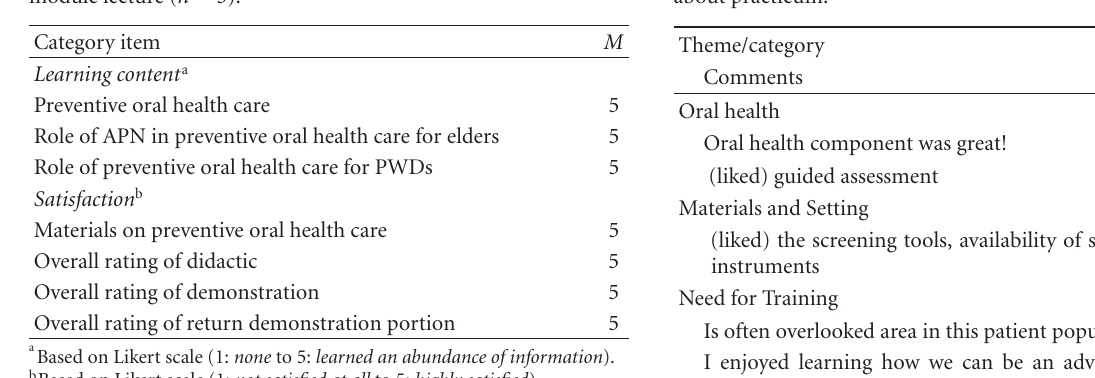
Table 4: Gerontological nurse practitioner evaluation of oral health module lecture ( n = 5).